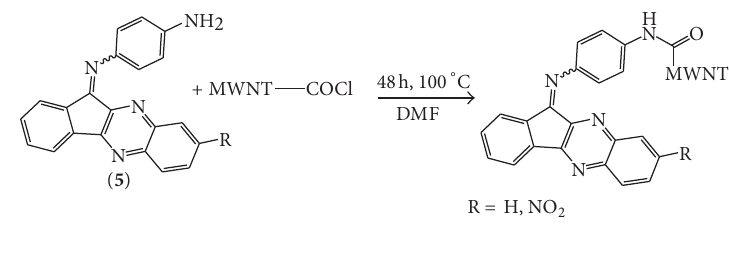
F 4: Preparation of MWNT-5.